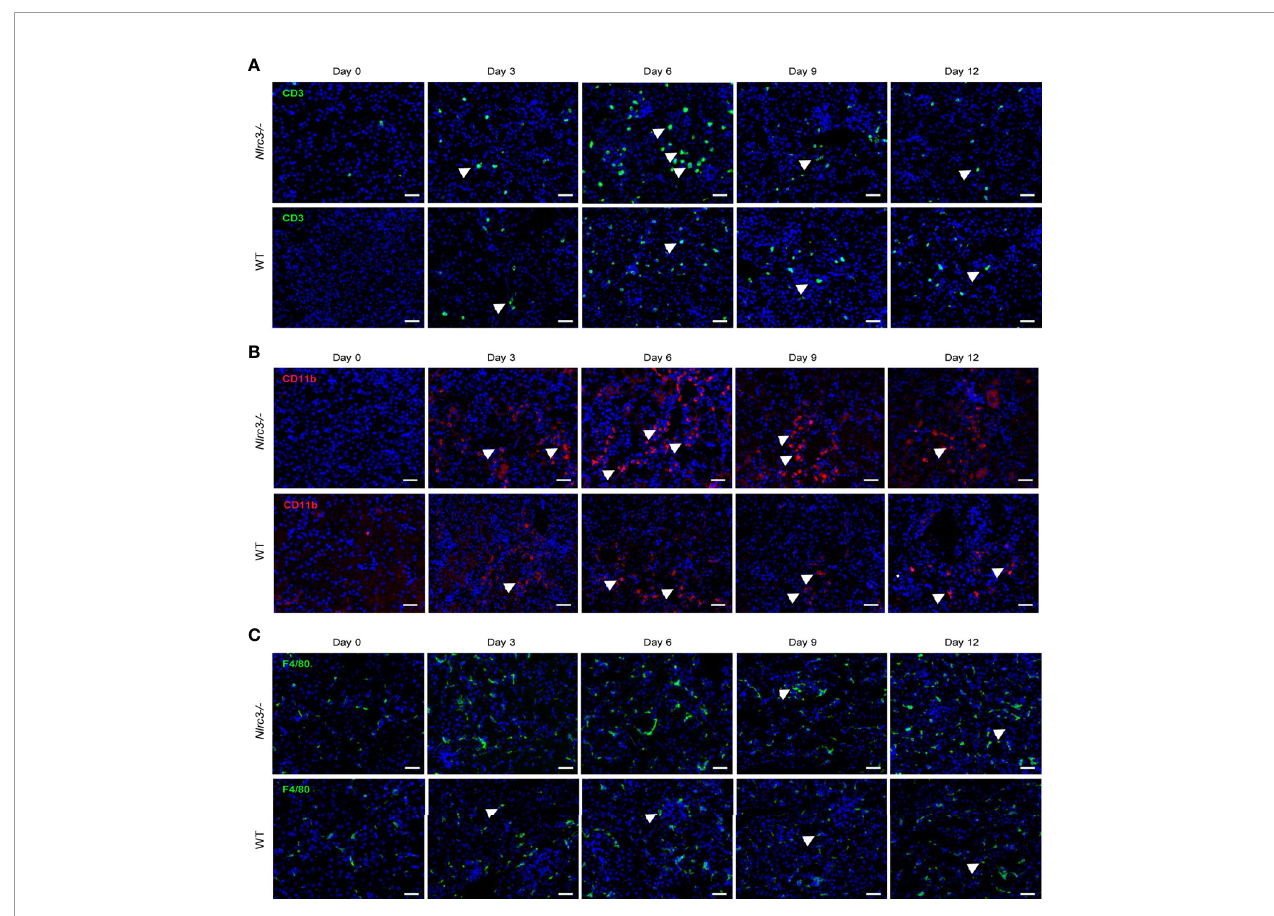
FIGURE 5 | IHC staining for in fl ammatory cell in fi ltration in the kidney of HTNV infected mice. (A) A representative image of IHC assay and CD3 was used to detect the in fi ltration of in fl ammatory T cells. The upper panel shows the kidney of Nlrc3 − / − mice; the lower panel shows the kidney of WT mice. Green signals represent CD3, and blue indicates cell nucleus. (B) Representative image of IHC staining for CD11b of the kidney of HTNV infected mice. CD11b was used to detect myeloid cells, and Upper panel shows the kidney of Nlrc3 − / − mice; the lower panel shows the kidney of WT mice. Red signals represent CD11b; Blue signals represent DAPI. (C) Representative image of IHC staining for F4/80 of the kidney of HTNV infected mice. F4/80 was used to detect macrophages. The upper panel shows the kidney of Nlrc3 − / − mice; the lower panel shows the kidney of WT mice. Green signals represent F4/80; Blue signals represent DAPI. IHC images are representative of at least three samples. Scale bars, 50 m